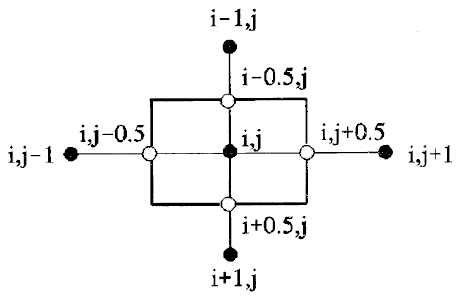
Figure 2. Five-point star.